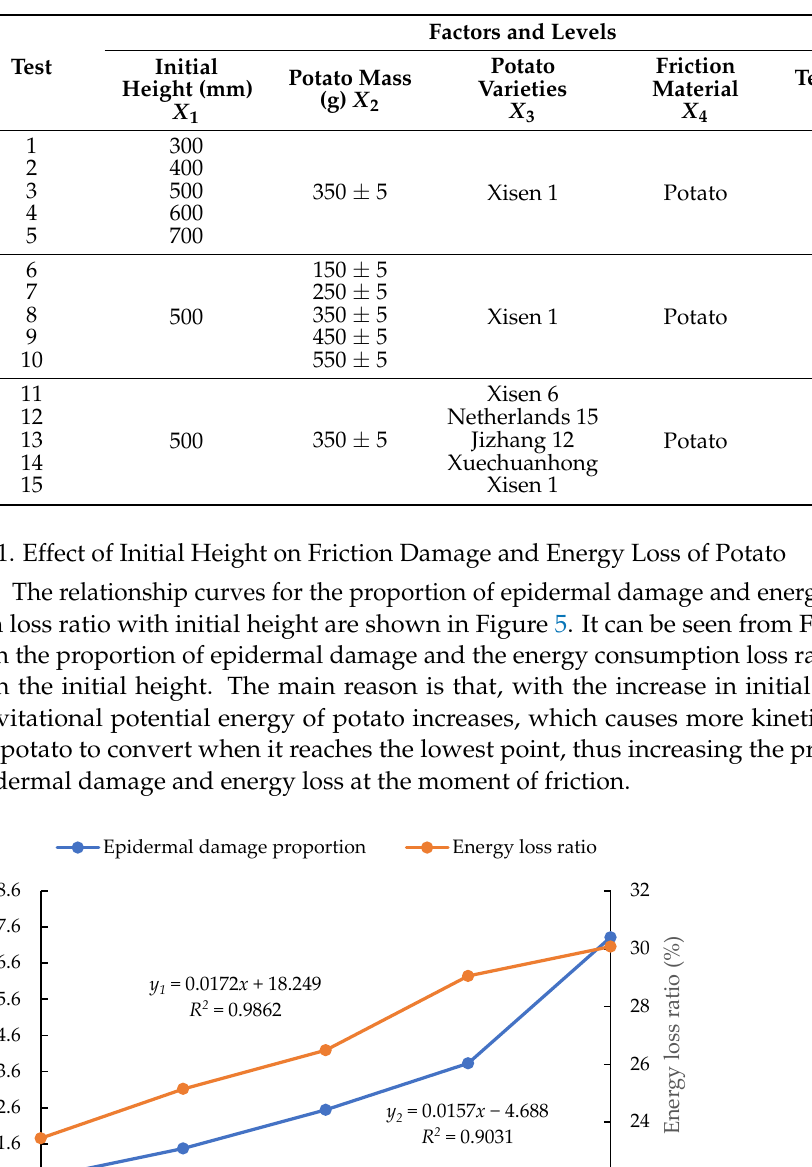
Table 4. Single factor test scheme.